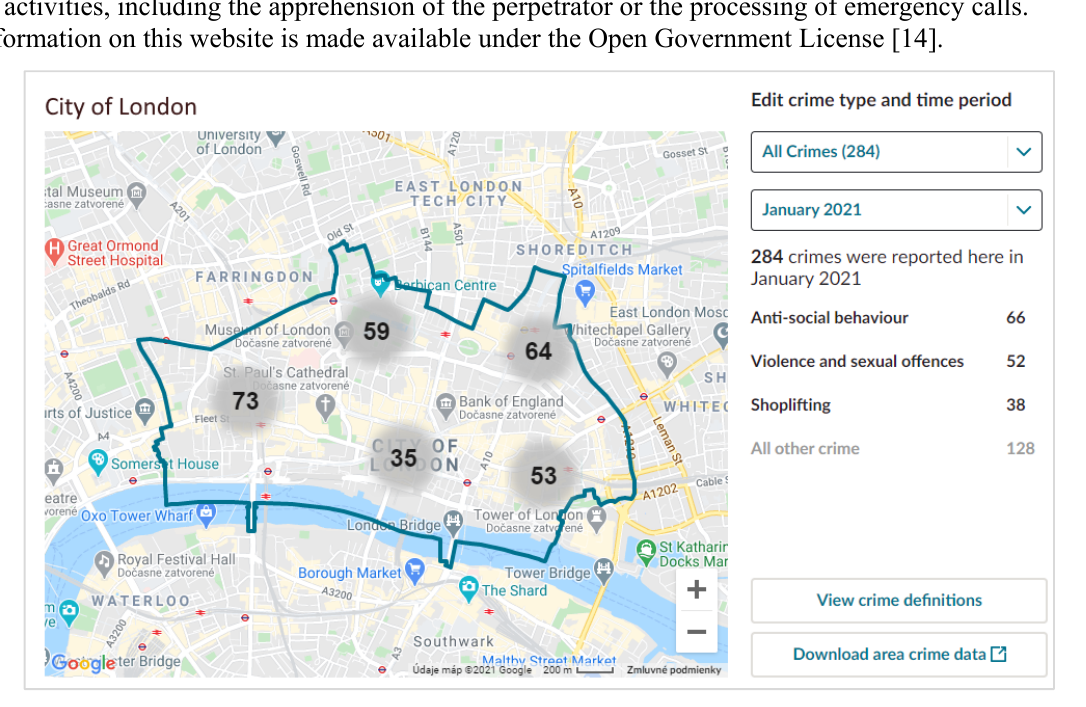
Figure 4. Crime in the city of London [14]